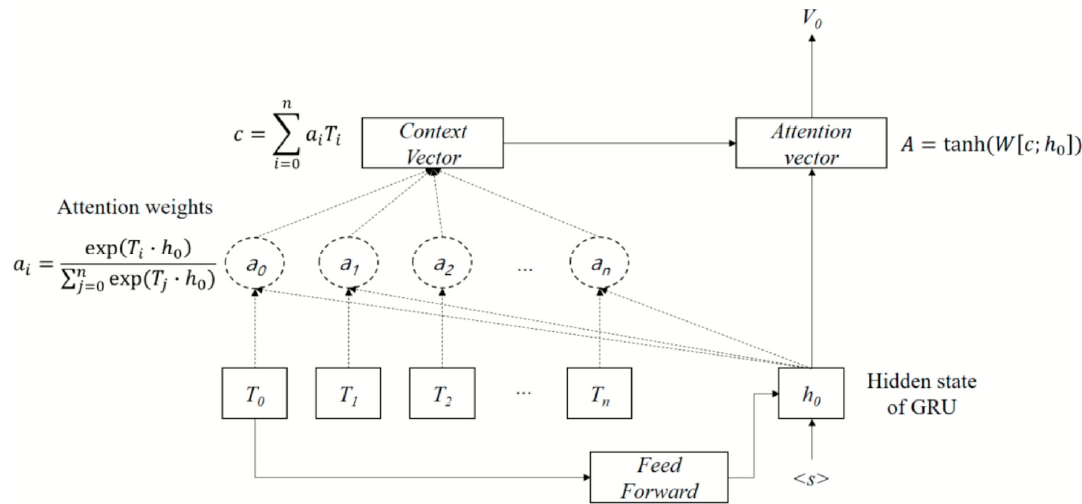
Figure4. Figure 4. Recurrent neural network (RNN) decoder with Luong’s encoder-decoder attention mechanism.